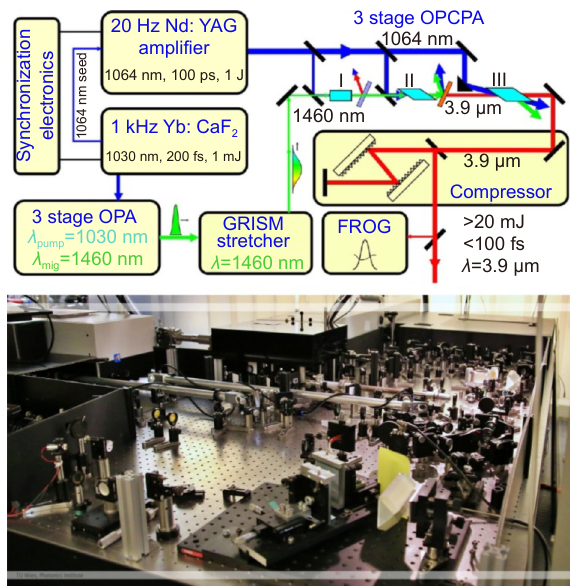
Fig. 8 | Layout of the 3.9 μm OPCPA system. Photo at the bottom: image of the back-end of the system. Image courtesy dr. A. Pugžlys, Photonics Institute, Technical University Wien. Figure reproduced with permission from ref. 175 , under a Creative Commons